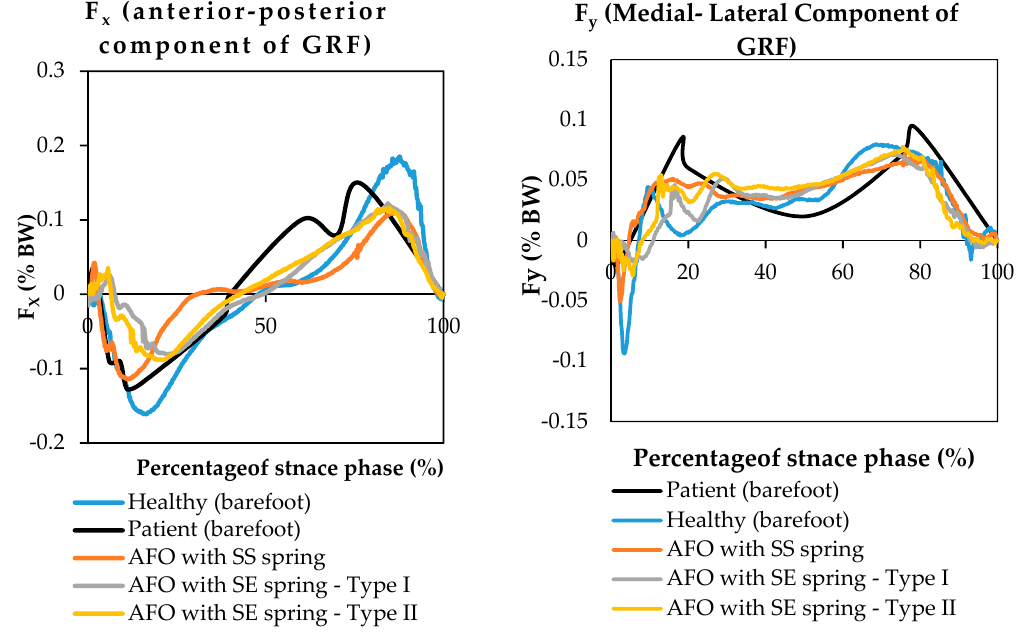
Figure 16. GRF during normal walking using AFO with Stainless Steel spring, AFO with superelastic NiTi spring (0.68 mm), and AFO with superelastic NiTi spring (1.07 mm) ( x , y , and z axis are presenting Anterior-Posterior, Medial-Lateral, and vertical components of ground reaction force) (Case II) [42]. Comparison of F z (vertical component of GRF) during normal walking using AFO with Stainless Steel spring, AFO with superelastic NiTi spring (0.68 mm), and AFO with superelastic NiTi